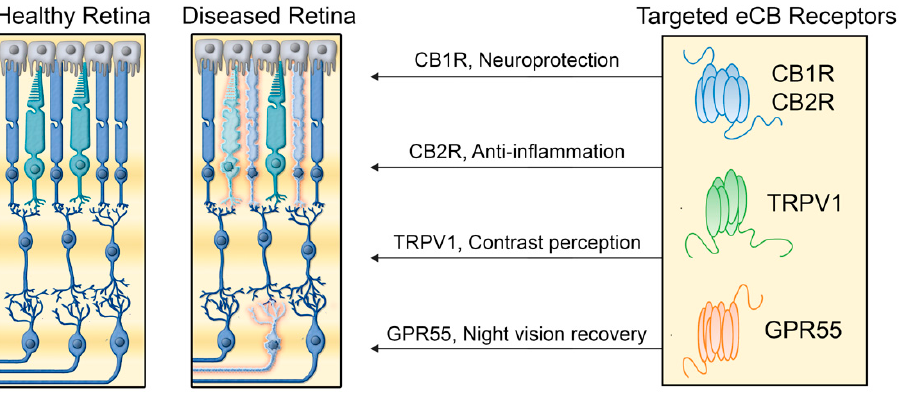
Figure 7. The main proposed mechanisms for the therapeutic effects of typical and atypical cannabinoid receptors in retinal diseases. Cannabinoid receptors can possibly contribute to treatment of retinal disorders by different mechanisms involving cannabinoid receptor type 1, cannabinoid receptor type 2, GPR55, and TRPV1 receptors.